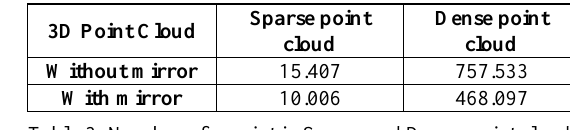
Table 3: Number of a point in Sparse and Dense point clouds